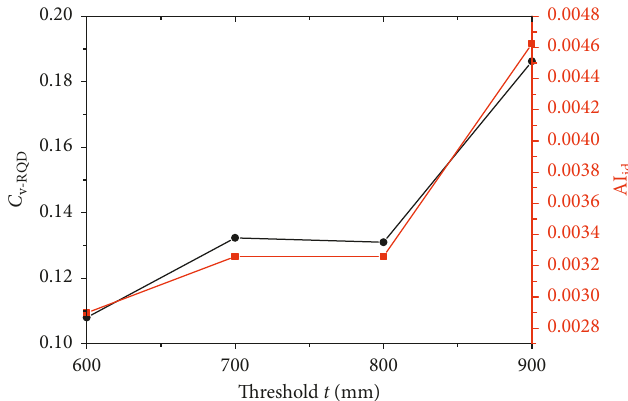
Figure 7: C v-RQD and AI jd of the RQD t values with reasonable